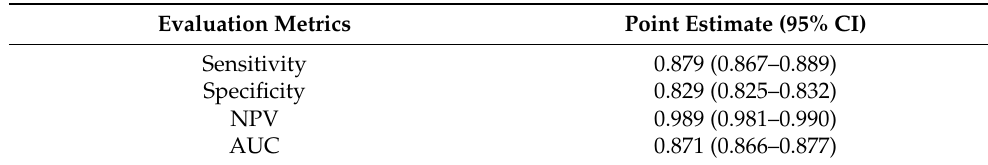
Table 1. Performance of qXR in categorizing normal or abnormal CXR using radiologist as reference standard. negative predictive value (NPV); confidence interval